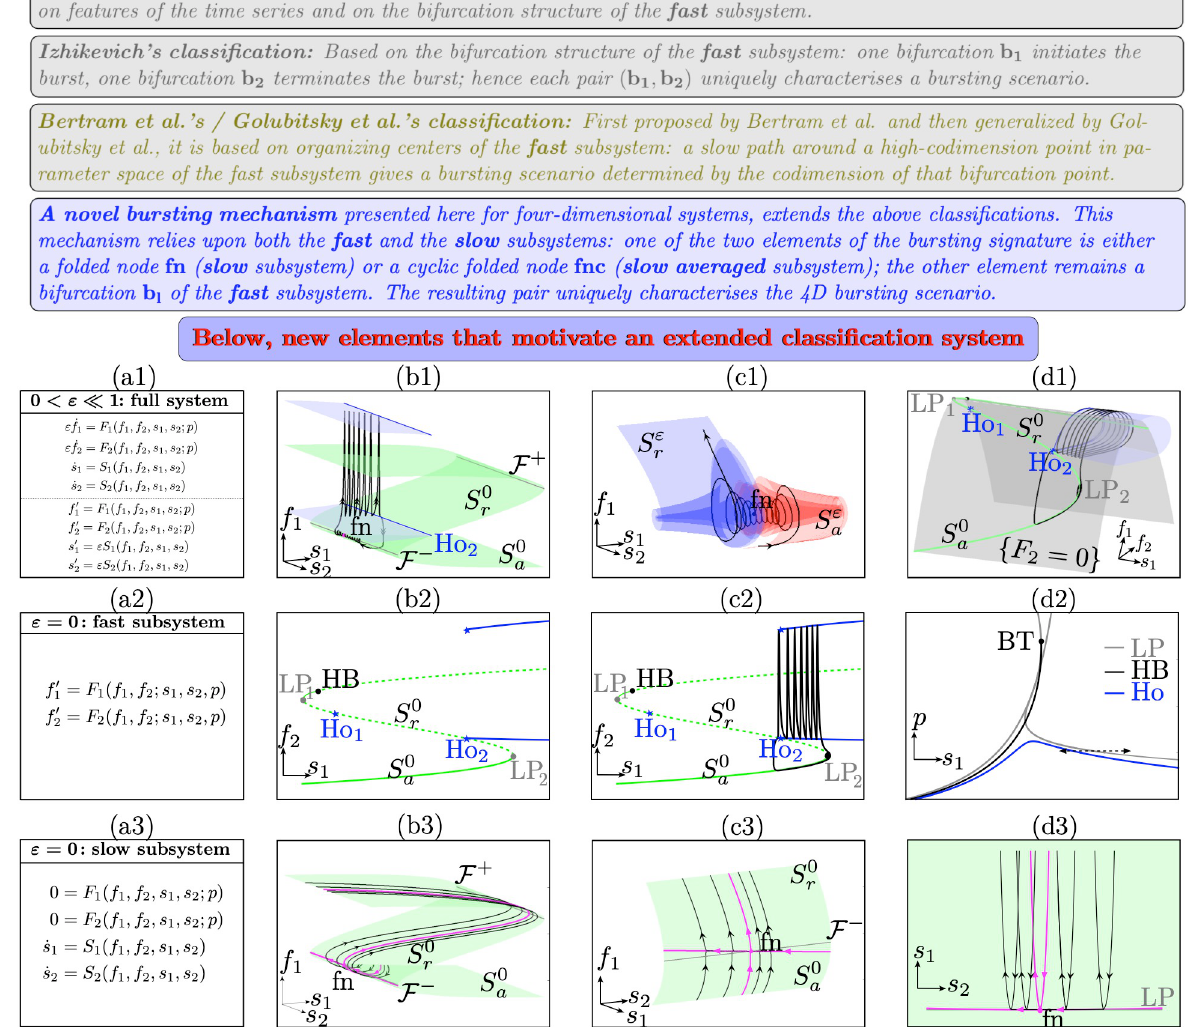
Fig 7. Extended classification. (Top part) Main idea of the Rinzel/Izhikevich, Bertram/Golubitsky and colleagues and folded-node bursting classifications. ((ai)-(di), i = 1,2,3) Exemplary “folded-node/homoclinic” bursting, presented in the full 4D system and in its 2D fast and slow subsystems (resp.), showing that both subsystems are required to fully understand this bursting profile; all equations are given in the left column (a1)-(a3). Top row (b1)-(d1), full system bursting solution in 2 different 3D phase-space projections: 2 slow/1 fast in (b1)-(c1) and 1 slow/2 fast in (d1), also showing the critical manifold (fast subsystem’s set of equilibria, in green), the fast subsystem’s limit cycles envelope (blue), as well as relevant bifurcations. In (c1), the trajectory is zoomed near its small oscillations, which follow attracting (red) and repelling (blue) slow manifolds , perturbations of the attracting and repelling parts S 0 of the critical manifold, and pass near the folded node (dot). Middle row (b2)-(d2), fast S ε a ; r a ; r subsystem information : the bifurcation diagram with respect to 1 slow variable ( s 1 ) in (b2), which we can assume persists as such for a small interval of values of the other slow variable ( s 2 ); this allows to superimpose the projection of the full system bursting orbit (c2), as done in the Rinzel/ Izhikevich classification, and to compute loci of bifurcation points of this diagram in the 2-parameter plane ( s 1 , p ), as done in the Bertram/ Golubitsky and colleagues classification. However, both approaches classify this bursting pattern as fold/homoclinic (square-wave), hence failing to capture the reason for its small oscillations during quiescence, which can only be unraveled by studying the slow subsystem’s information in the bottom row (b3)-(c3) and find the existence of a folded node in the slow singular limit; details on labels in S1 Text.